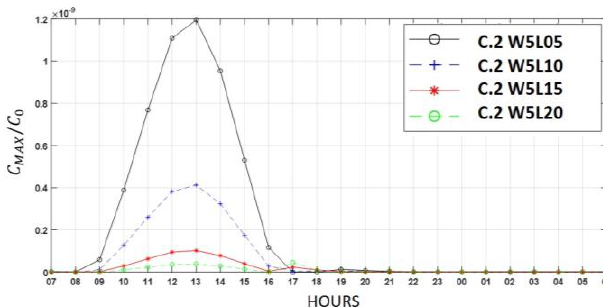
Fig. 6. Daily variation of the nondimensional maximum CO concentration C MAX /C 0 inside the courtyard 2, for the different simulated courtyard dimensions.